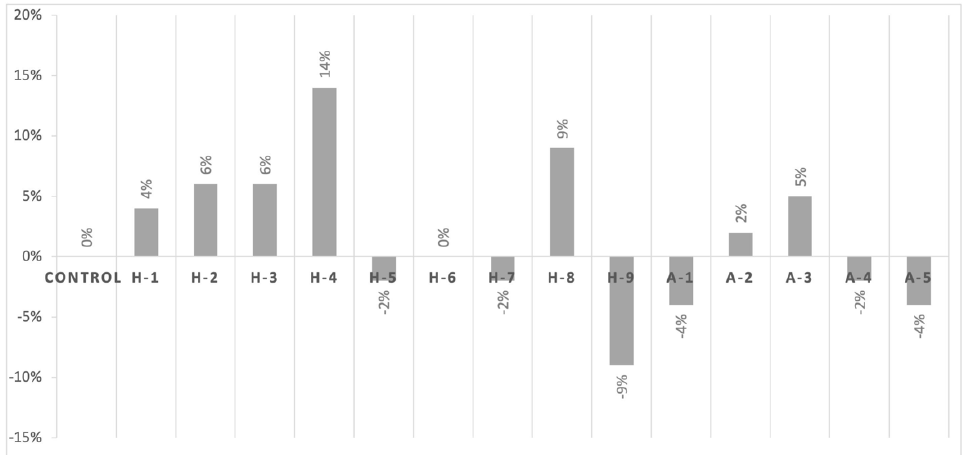
Figure 4. Percentage increase or decrease in the diameter of the inhibition zone when icariin is used in combination with vancomycin in respect to the control strain. Complete descriptions of the abbreviated strain names on the x -axis can be found in Table 1.